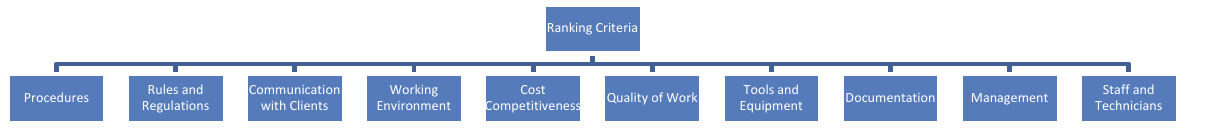
Fig. 2. The Ranking Criteria based on the SHELL